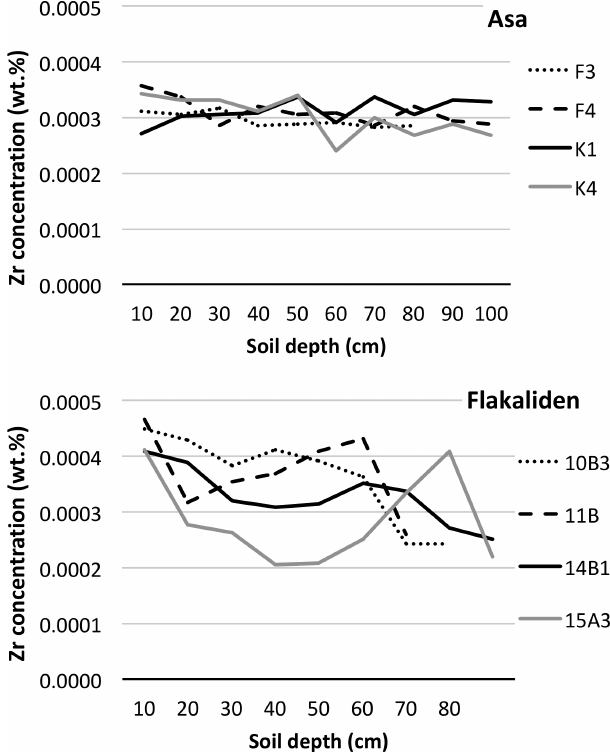
Figure 3. Zirconium (Zr) gradient in the soil at Asa (K1, K4, F3, F4) and Flakaliden (10B, 11B, 14B,